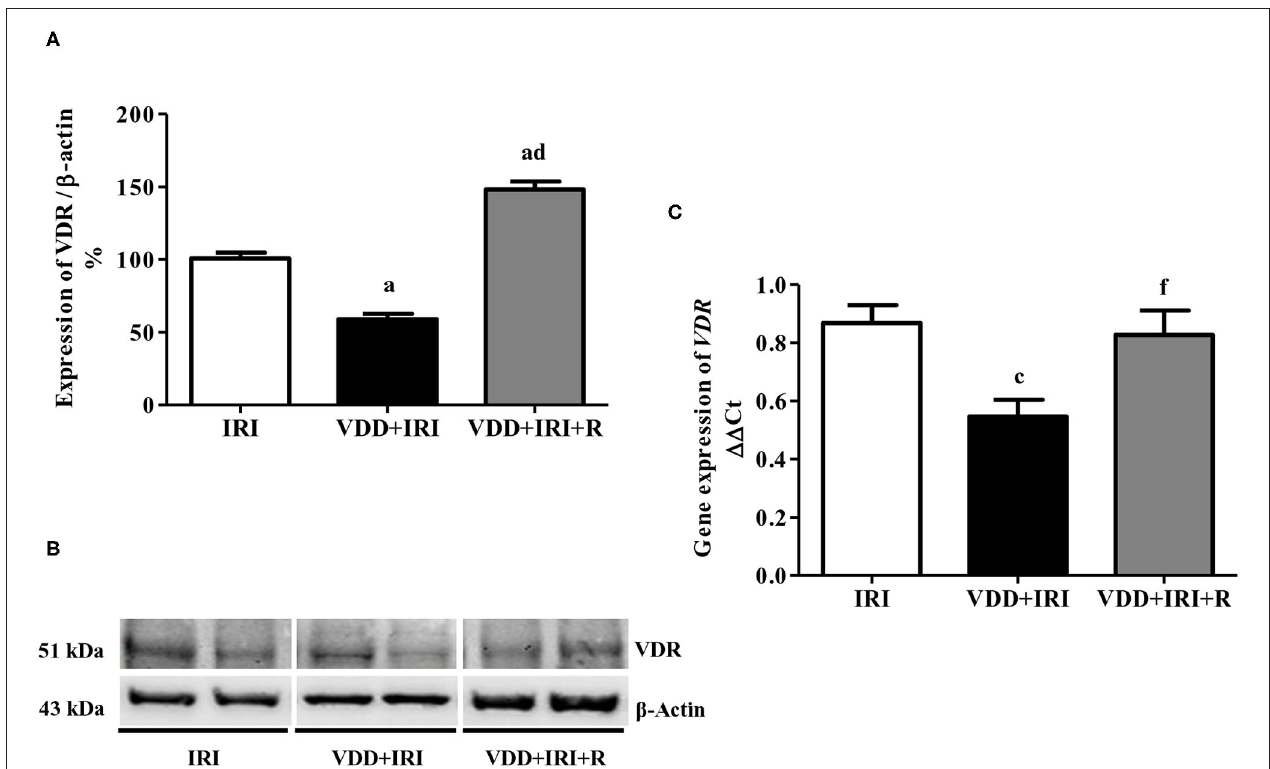
FIGURE 6 | Semiquantitative immunoblotting and real-time quantitative polymerase chain reaction for renal VDR expression evaluated 90 days after ischemia/reperfusion insult (IRI) on day 30. (A) Densitometric analysis of samples from IRI, VDD + IRI and VDD + IRI + R rats. (B) Representative immunoblots which reacted with anti-VDR revealing a 51 kDa band. (C) Bar graph of VDR gene expression values. Note that vitamin D replacement restored the expression of VDR in the VDD + IRI + R rats. Data are mean ± SEM. a p < 0.001, c p < 0.05 vs. IRI; d p < 0.001, f p < 0.05 vs. VDD + IRI. VDD, vitamin D deficiency; R, vitamin D